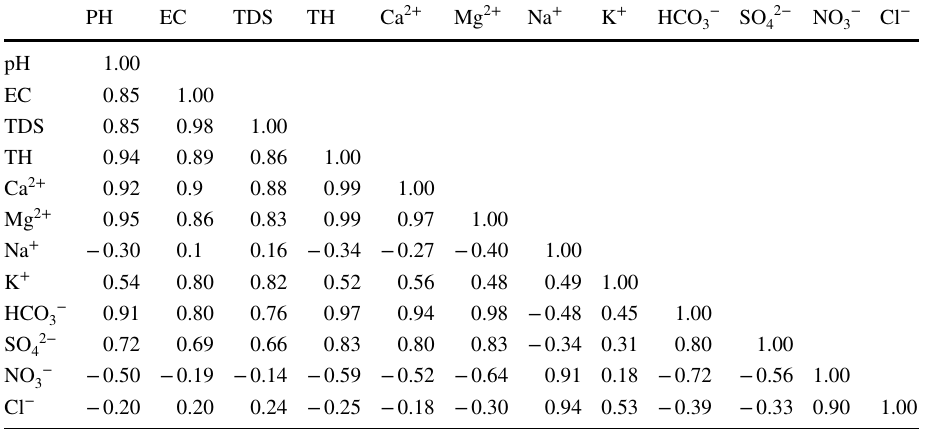
Table 4 Saturation indices and partial pressures of CO 2 of carbonate and evaporite minerals of the groundwater samples (saturated and supersaturated indices are in